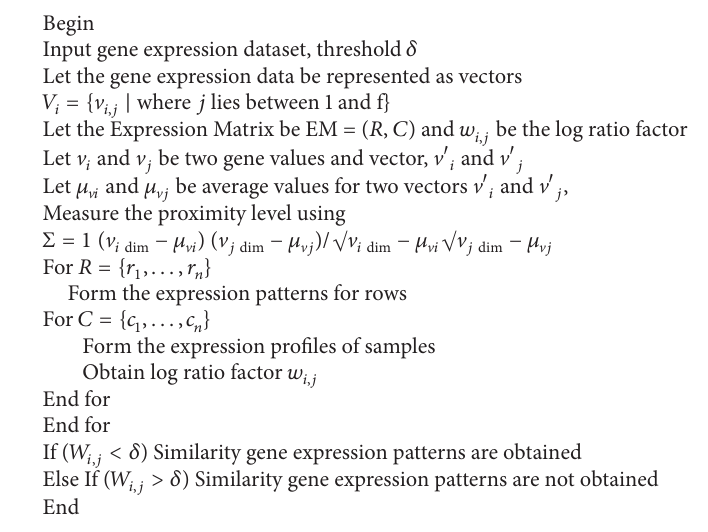
Algorithm 1: Hierarchical clustering algorithm to measure the similar gene expression pattern.